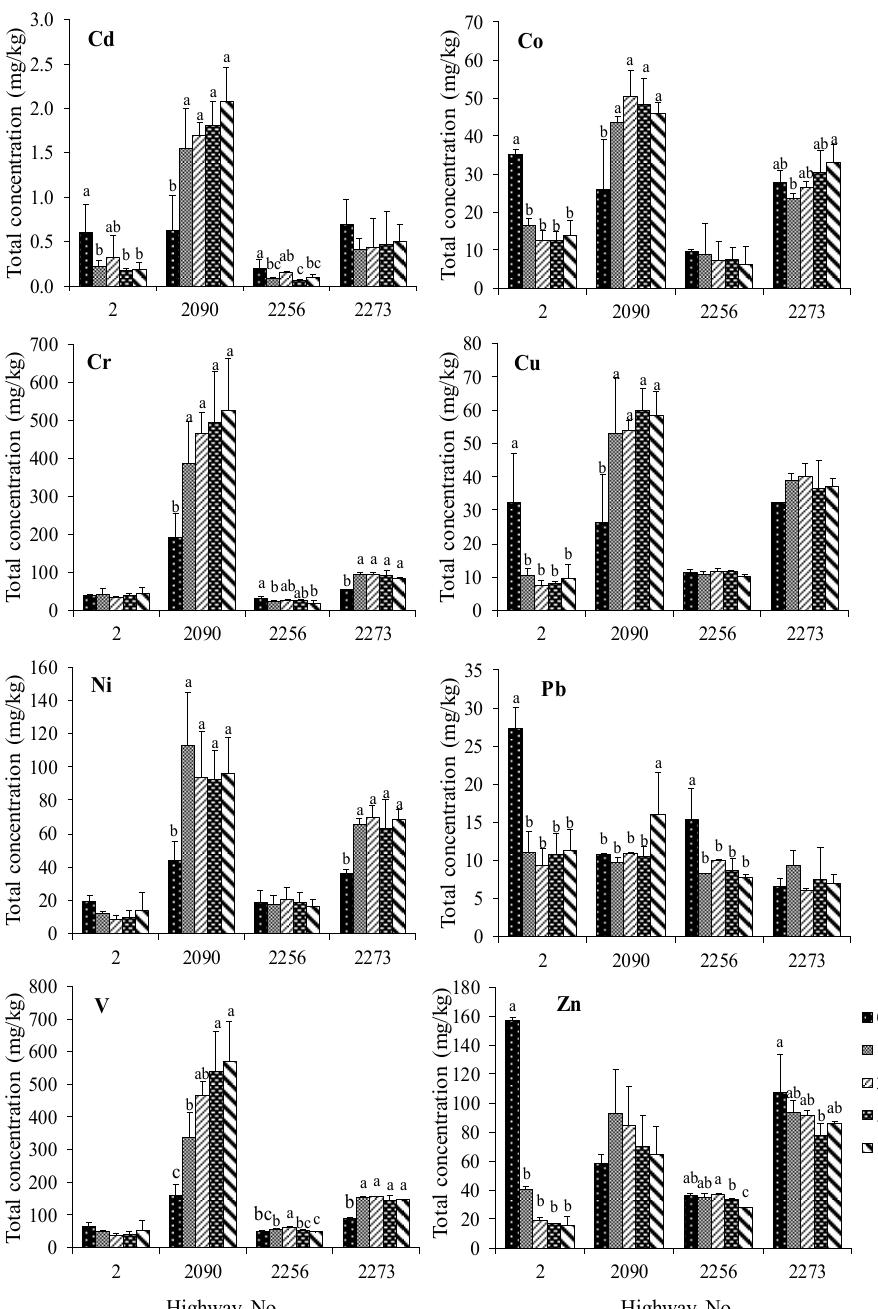
Figure 3. Mean total concentrations of Cd, Co, Cr, Cu, Ni, Pb, V, and Zn (mg kg − 1 ) in maize growing soils at different distances from the road edge. The columns with different alphabets indicate significant differences and those without alphabets indicate insignificant differences in the soil concentrations ( p < 0.05), and error bars indicate ±SD.